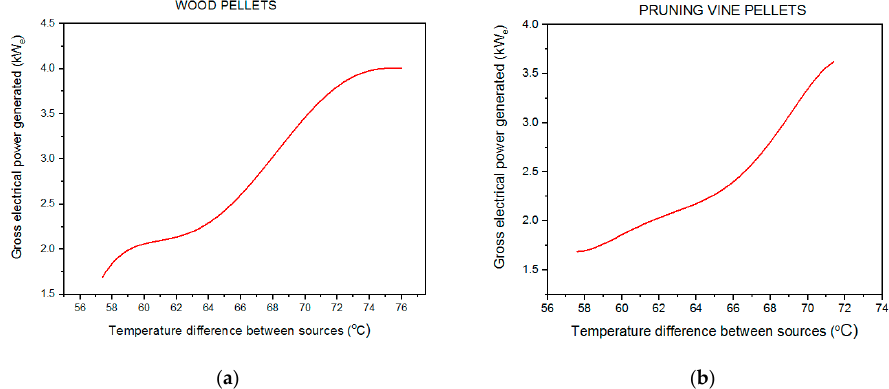
Figure 3. Gross electrical power generated in the ORC according to dissipation conditions used: ( a ) pine pellets and ( b ) vine pruning pellets.